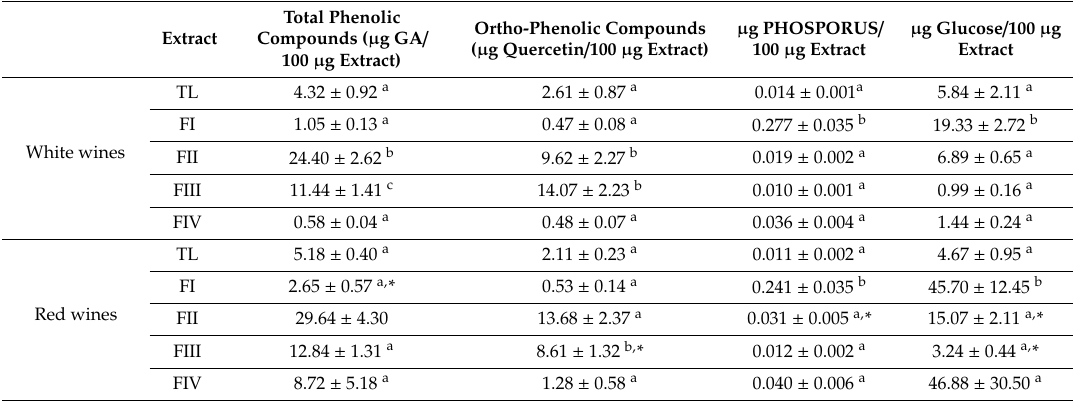
Table 1. Chemical determinations in wines per extract type and per wine color.